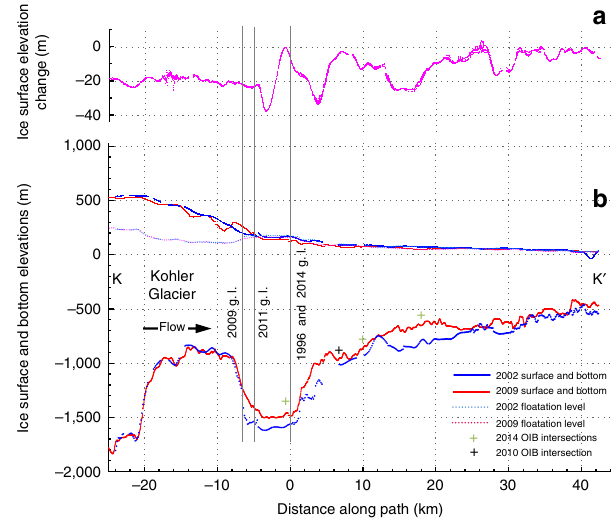
Figure 3 | Pope Glacier radar transects showing basal ice losses and corresponding surface elevation changes between the years 2002 and 2009. ( a ) Surface elevation change between 2002 and 2009 as measured by ATM laser altimetry on the along-flow Pope Glacier (PG) transect delimited by P-P 0 shown in Fig. 1a. ( b ) The 2002 and 2009 ice surface and bottom MCoRDS profiles of PG along the transect delimited by P-P 0 in Fig. 1a. The hydrostatic floatation levels were found as described in the caption of Fig. 2b. in 2009 after thinning. With the ice being afloat, the surface lowering numbers therefore corroborate the thinning observed by the radar sounding. The thinning in 7 years represents 22% of the ice thickness at (cid:2) 112.88 (cid:2) (Fig. 2b). A location of similarly high the western margin of the glacier at (cid:2) 113.05 (cid:2) (Fig. 2a,b). In the